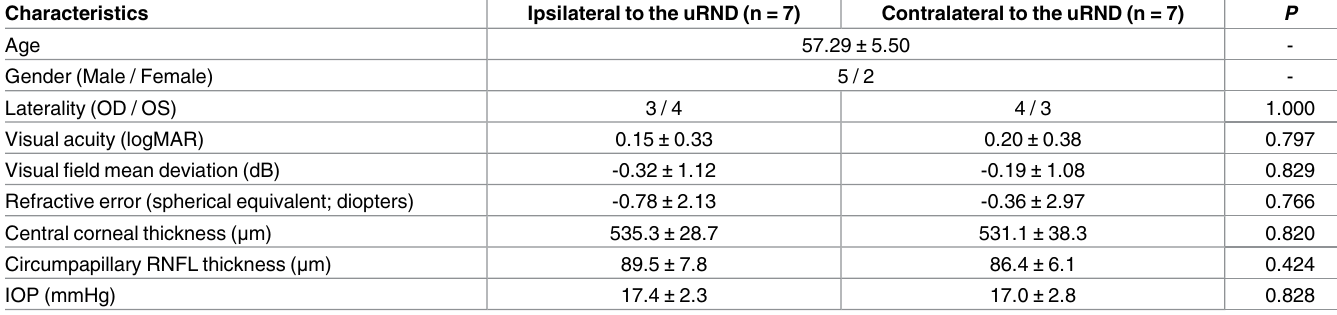
Table 2. Baseline characteristics of GS eyes ipsilateral to the uRND and in GS eyescontralateral to the uRND.